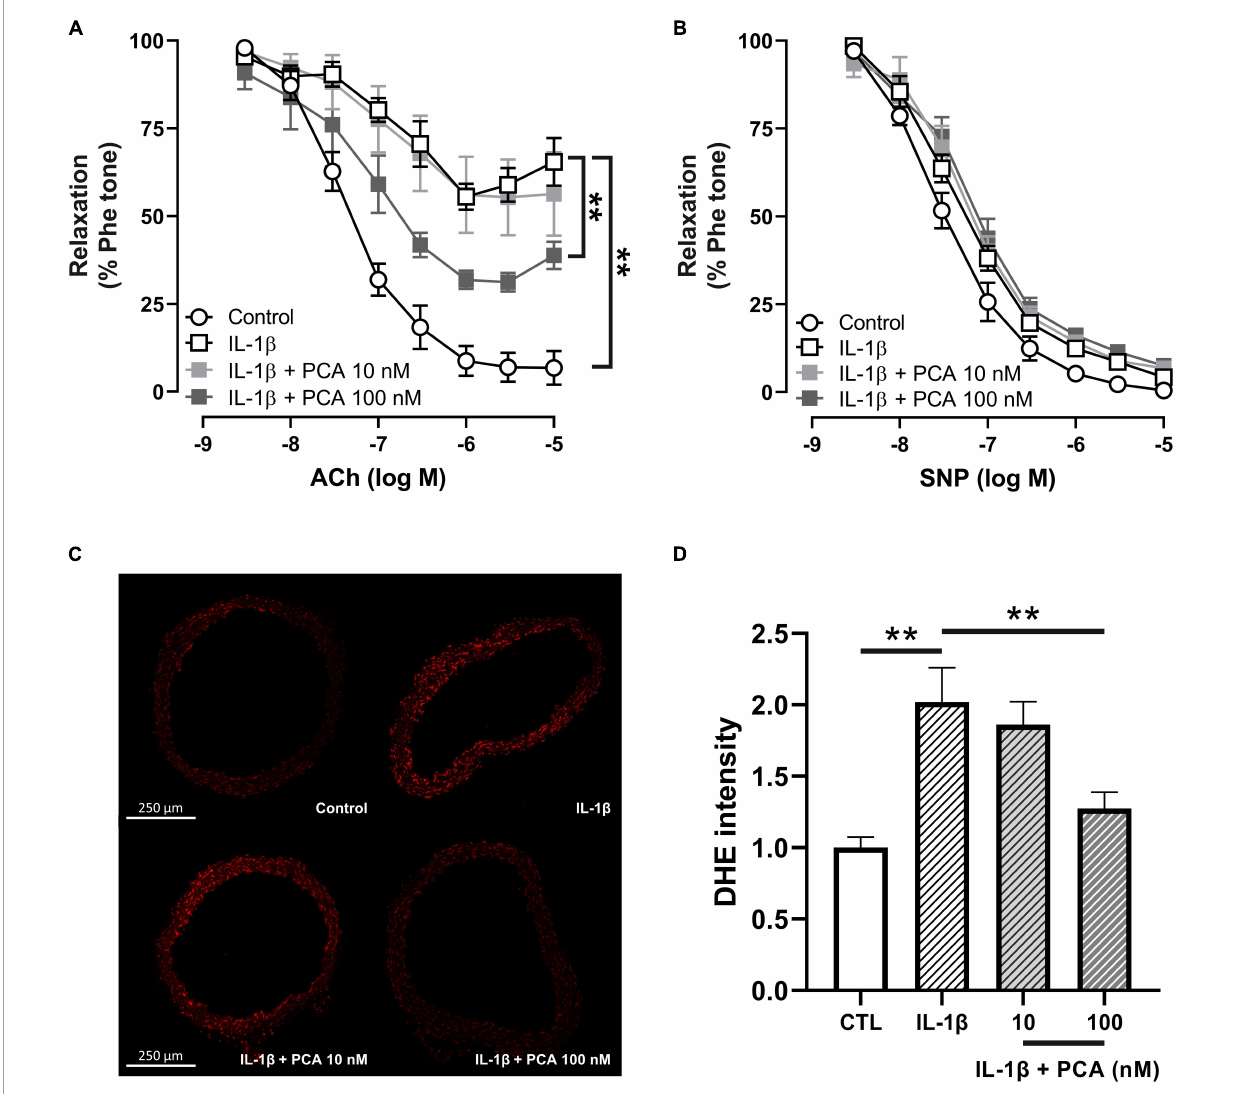
FIGURE2 PCA alleviated the impaired EDR and ROS overproduction in C57BL/6J mouse aortas treated with IL-1 β . Summarized data (A) of EDR and endothelium-independent relaxation (B) measured by wire myograph in IL-1 β -treated aortas from male C57BL/6J mice incubated with and without PCA (10 – 100 nM); n = 5. Representative confocal images (C) and summarized data (D) of DHE stain intensity in aortic rings from C57BL/6J mice with and without PCA incubation (10- 100 nM); n = 6-7. Data are presented in means ± SEM; ** p < 0.01. PCA, protocatechuic acid; Phe, phenylephrine; ACh, acetylcholine; SNP, sodium nitroprusside; DHE,